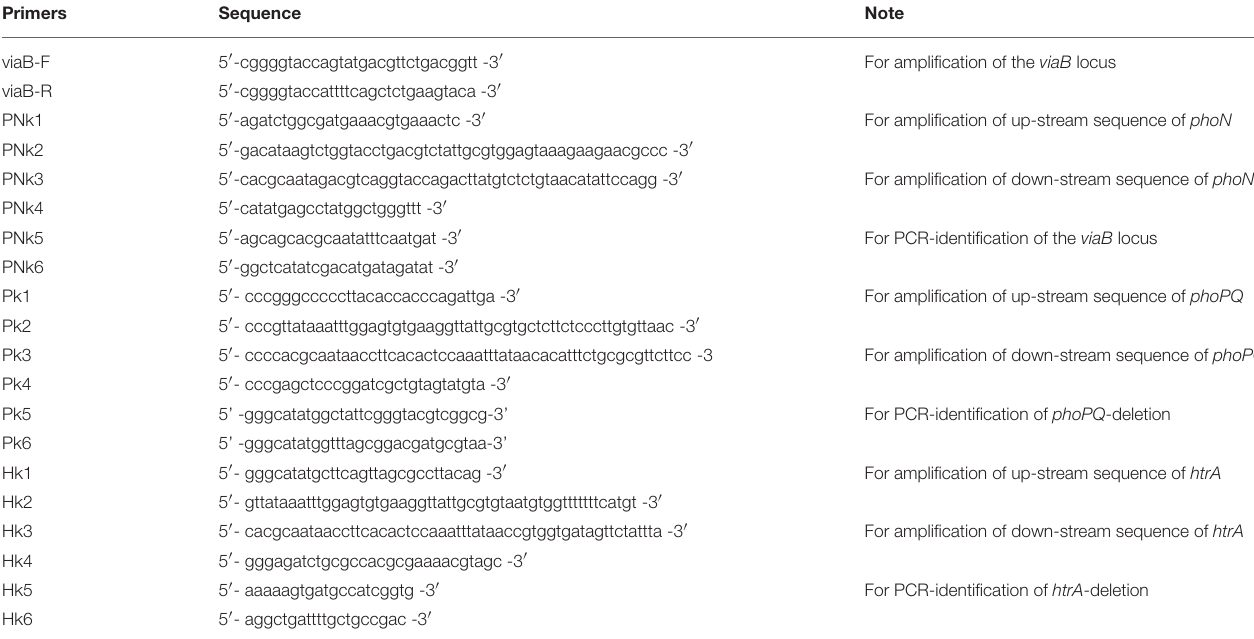
TABLE 1 | List of primers used in the present study.